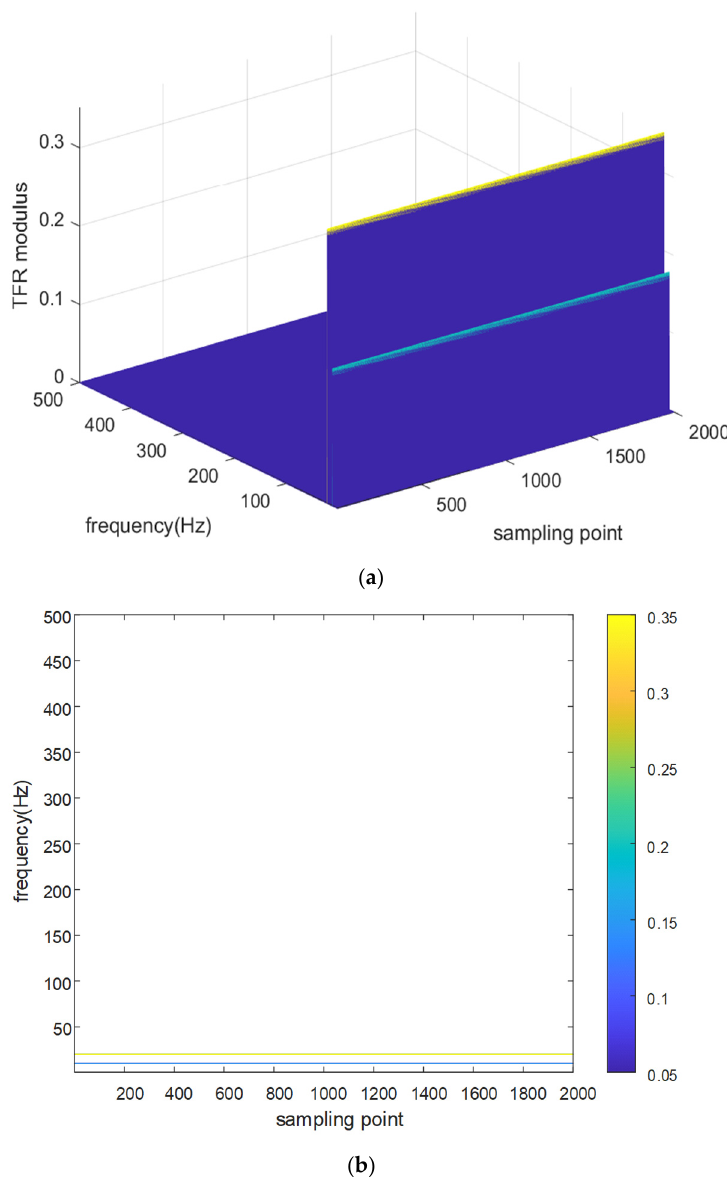
Figure 1. Illustration of SST on f(t). ( a ) The reassigned CWT TFR and ( b ) its contour. It can be seen that the sinusoids of f ( t ) are well-separated from each other and easily recognized. Intuitively, the enhanced TFR have “flat ridges” in the 3-D coordinate, or straight lines parallel to time axis in the 2-D coordinate. In fact, on the contour time-fre- quency plane, each of the parallel line corresponds to a unique IF value. The IF line can be seen as a unique characteristic and also the existing symbol for sinusoids.